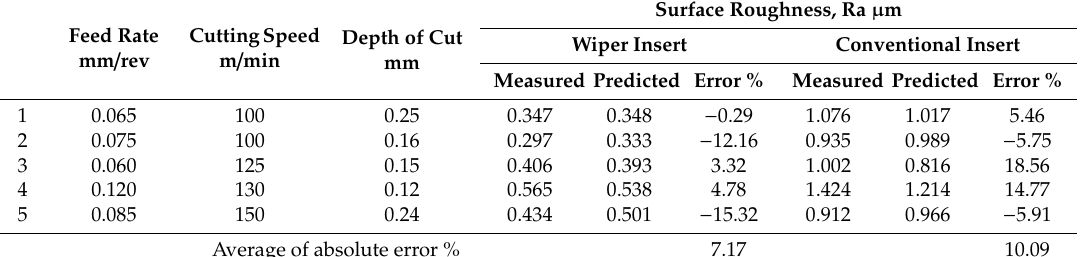
Table 3. Turning validation results of the proposed regression model: measured vs. predicted